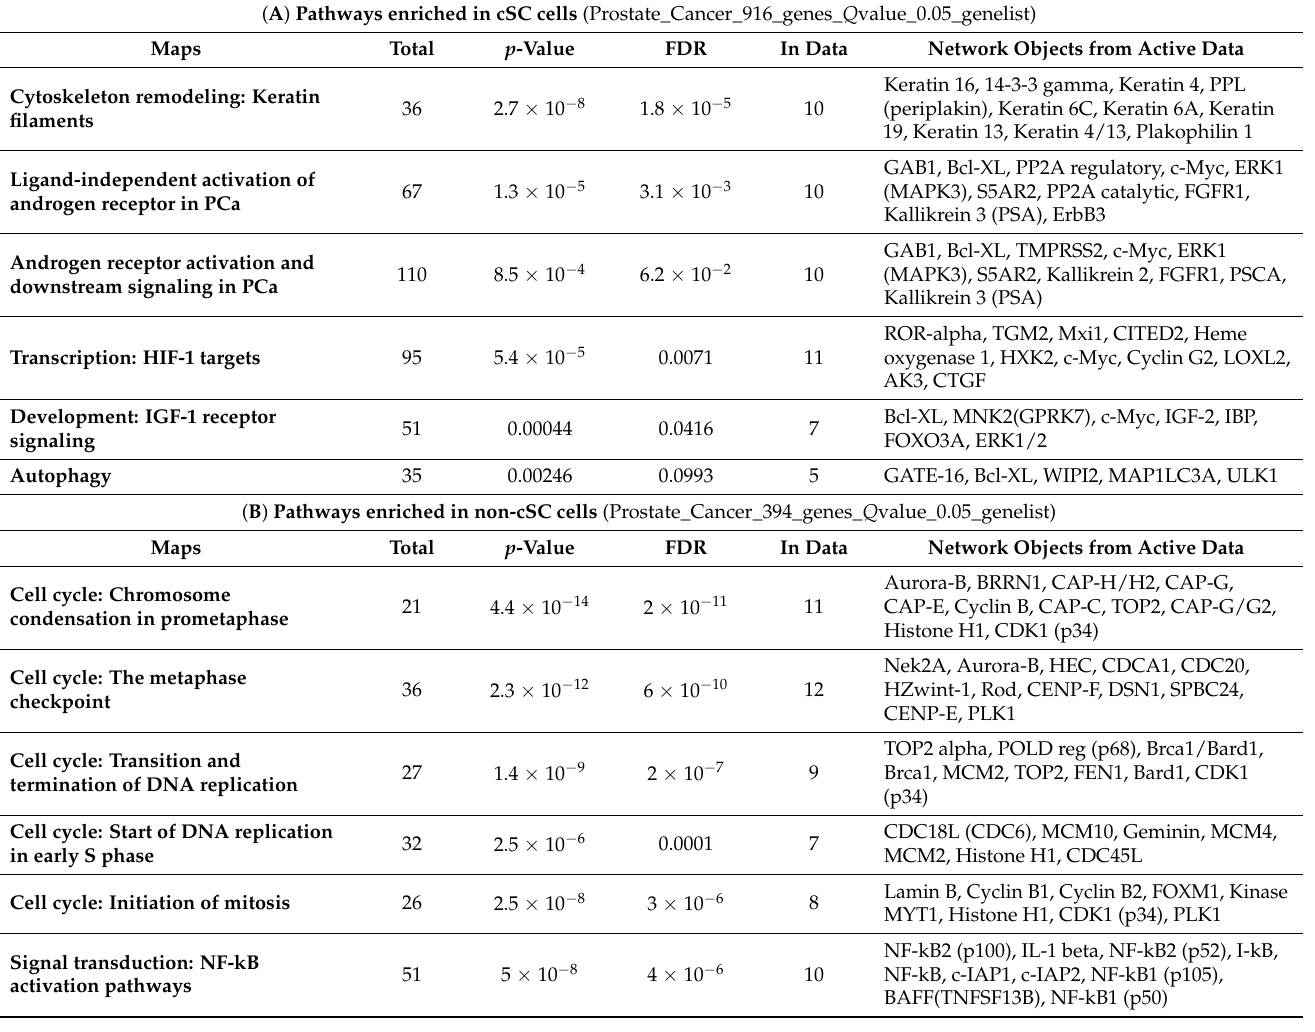
Table 2. Enriched pathways in cSC cells ( A ) and non-cSC cells ( B ) by MetaCore Enrichment